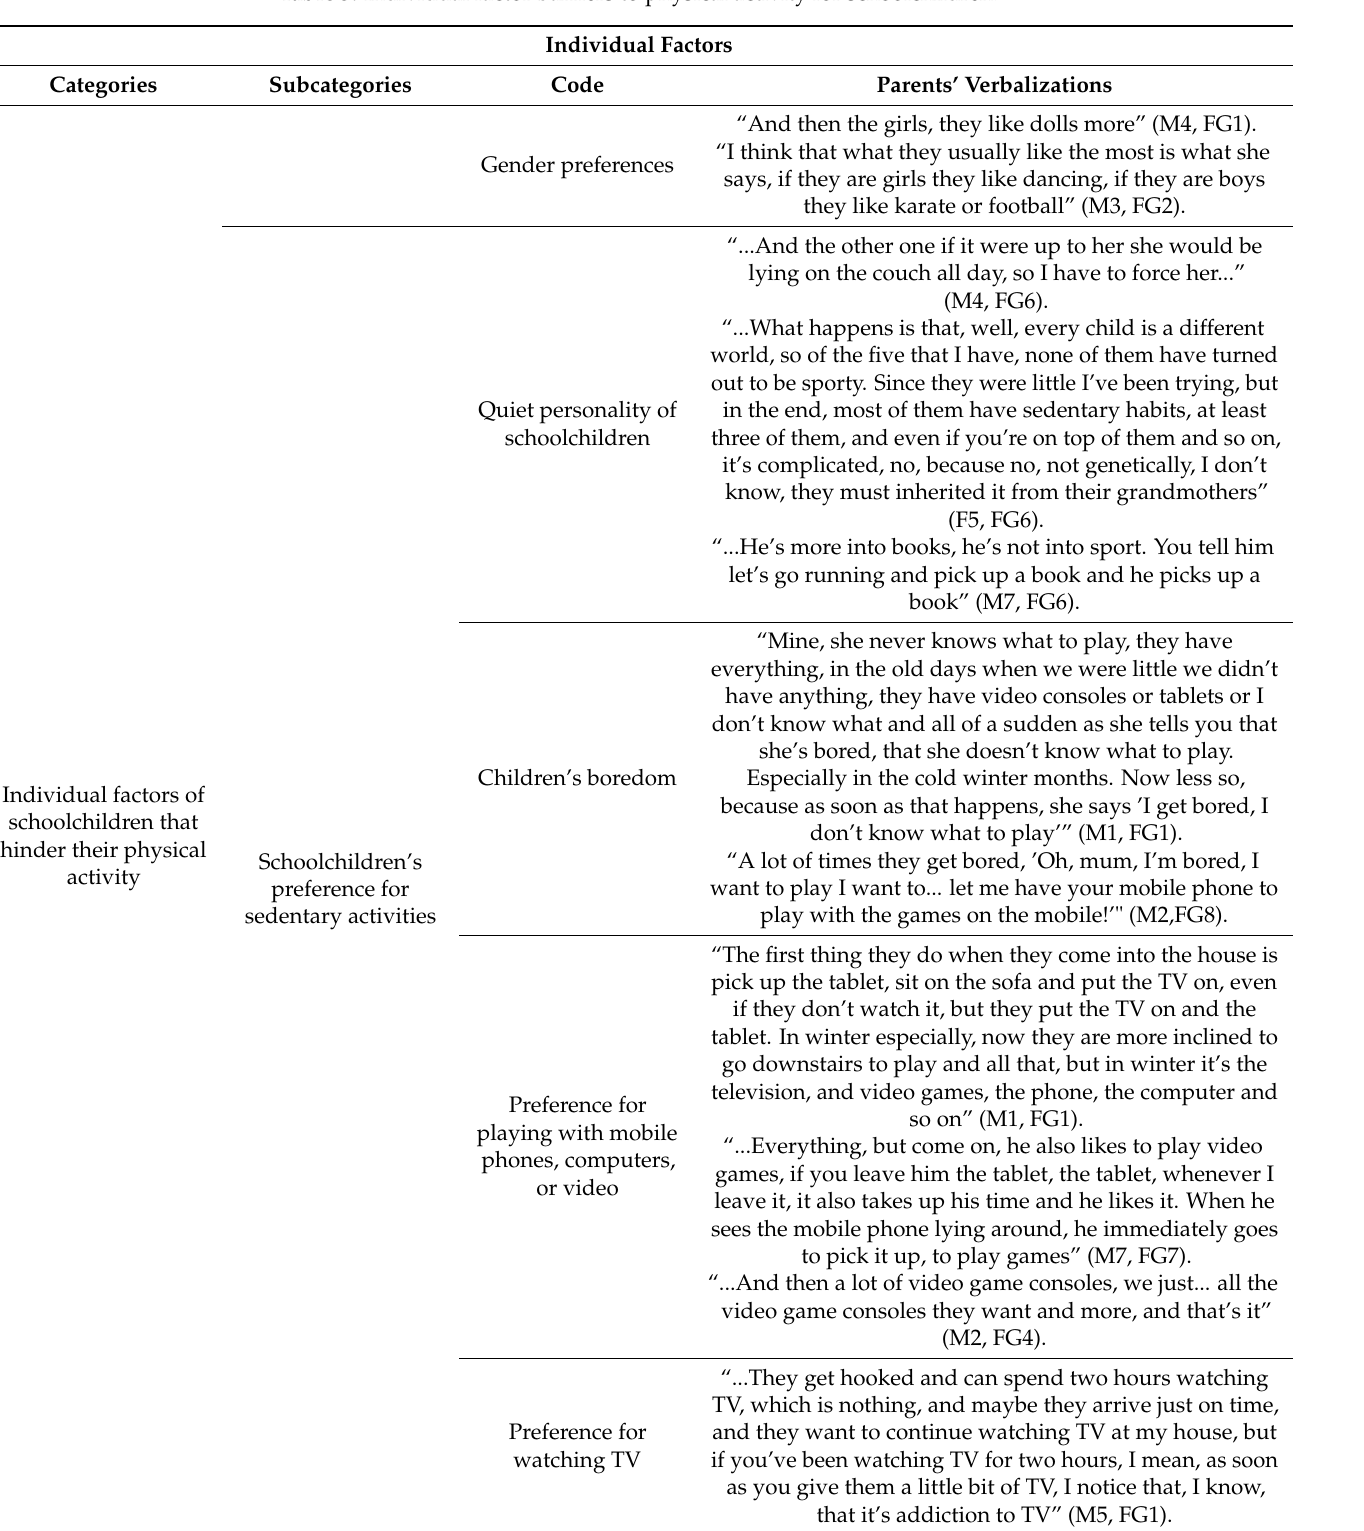
Table 3. Individual factor barriers to physical activity for